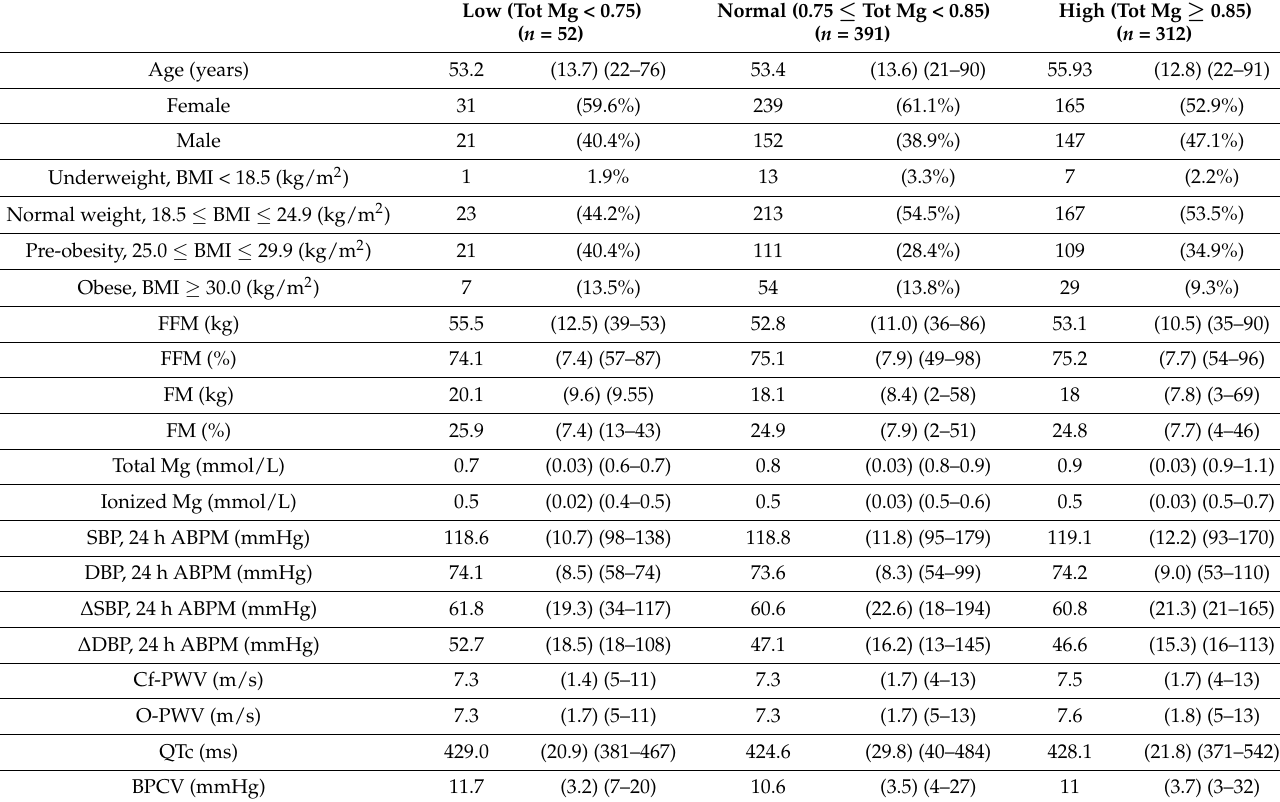
Table A4. Patients’ characteristics—Classification 1 Total